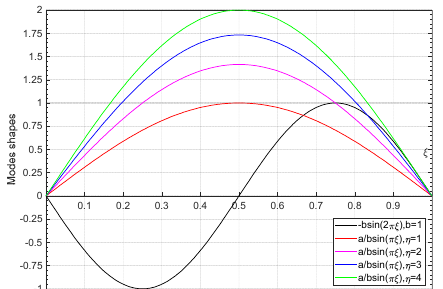
Figure 2. Mode configurations on the panel flutter occurrence with different η .